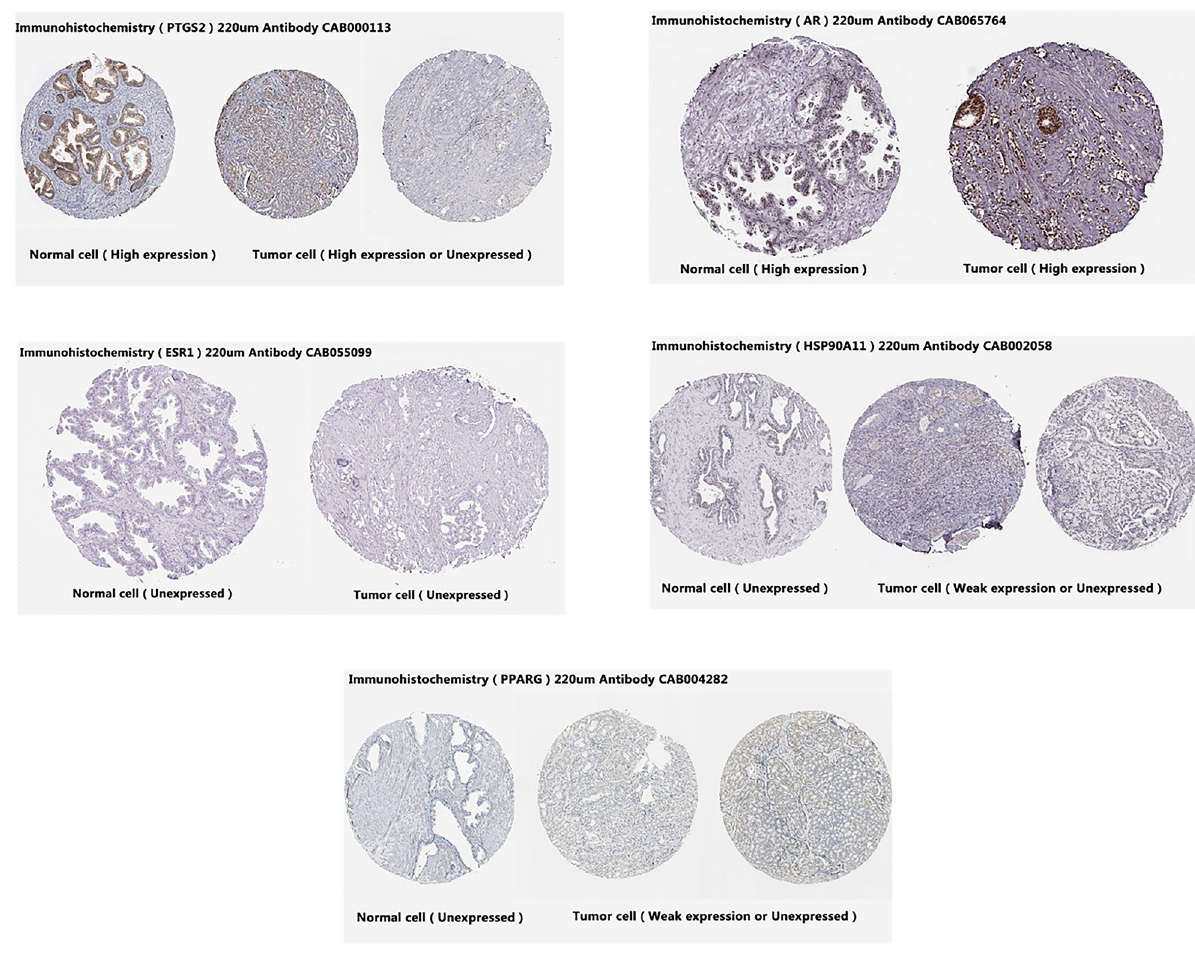
Fig 7. Immunohistochemistry. The expressions of 5 targets in prostate tissues of cancer patients and normal people.